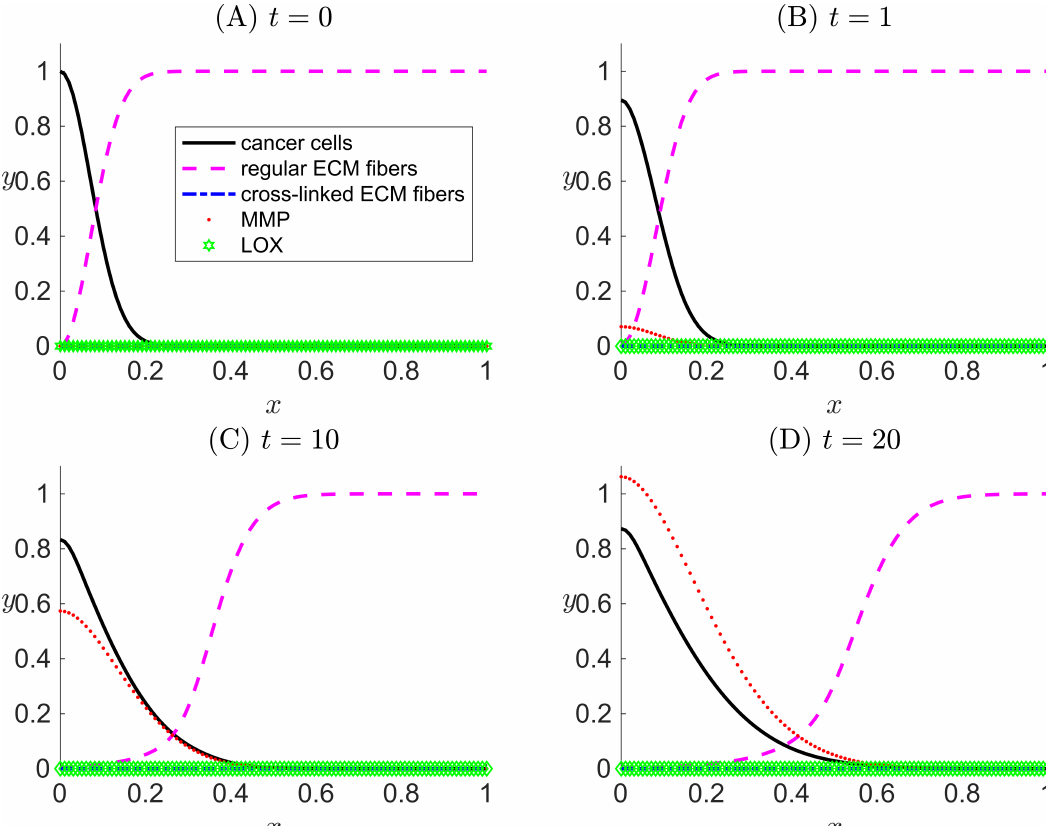
Figure 2. One-dimensional numerical results for Case I when there is zero concentration of LOX ( l ≡ 0) and hence, zero cross-linked ECM collagen fibers f cl in the system. Results are snapshots of the system dynamics at four simulation times: ( A ) t = 0, ( B ) t = 1, ( C ) t = 10, and ( D ) t = 20. For all four plots, the horizontal axis x indicates the dimensionless spatial position, and the vertical axis y indicates the dimensionless population density or concentration of the species listed in the